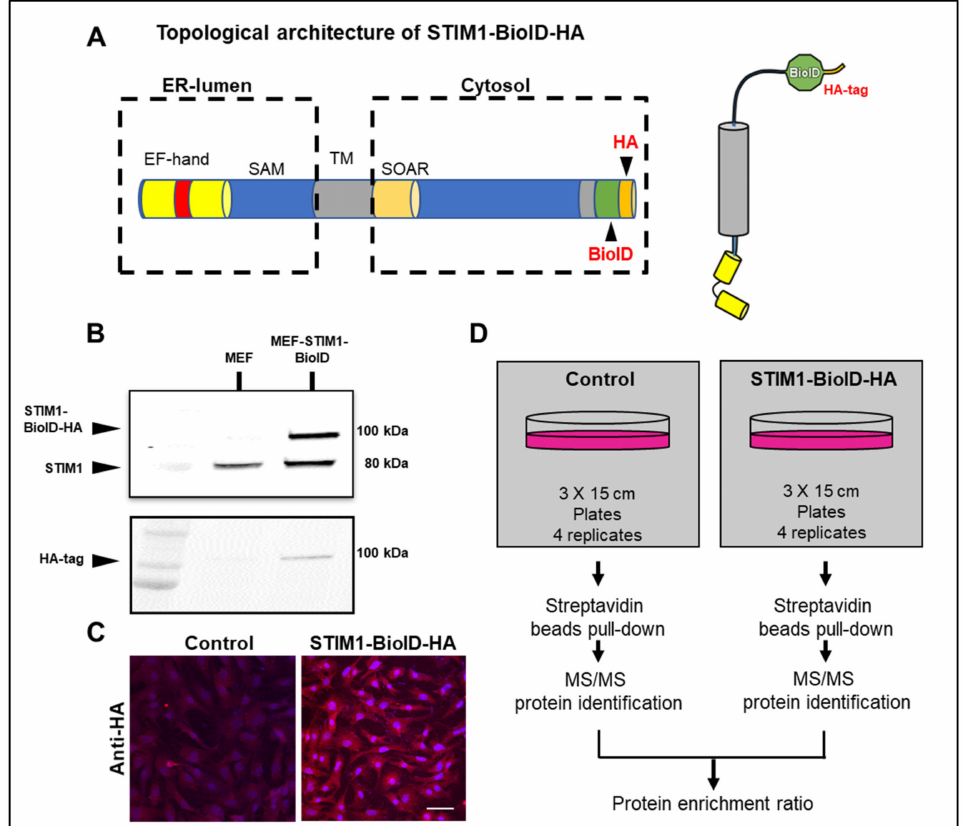
Figure 1. Generation of STIM1-BioID construct and BioID assay workflow. ( A ) Schematic representa- tion of the mammalian STIM1 protein with color-coded domains, BioID- and HA-tag were positioned at the STIM1 C-terminus. ( B ) Expression of STIM1 and STIM1-BioID was validated with Western blot and antibodies against STIM1 and Anti-HA-tag. ( C ) Confocal images of immunofluorescence staining of fixed control and MEF-STIM1-BioID. Cells were stained with DAPI and anti-HA-tag, pictures were taken at 405 nm and 564 nm. Scale bar: 20 µ m. ( D ) Biotinylation and mass spectrometry (MS) analysis workflow: cultured control and MEF- STIM1-BioID were incubated with biotin provided in the media for 16 h and then lysed under stringent conditions. Biotinylated proteins were collected on streptavidin-conjugated beads for subsequent analysis and